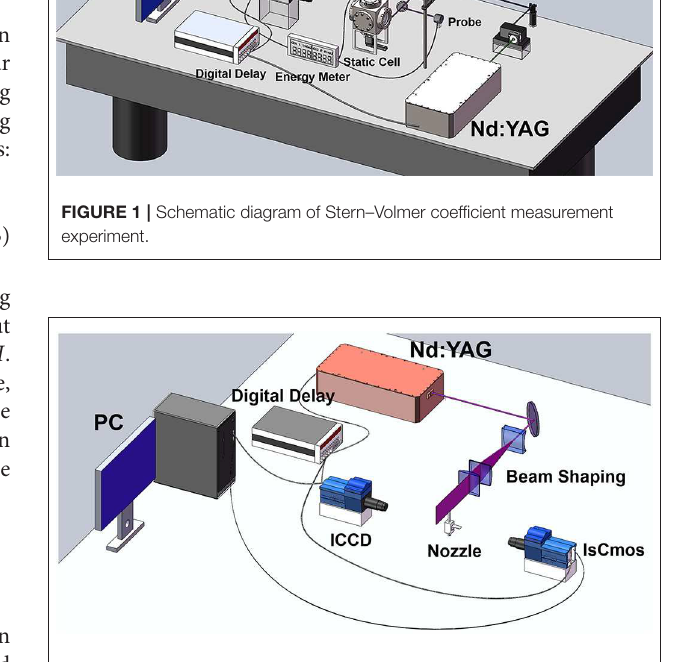
a sheet (0.1 mm × 35 mm) using three cylindrical lens,